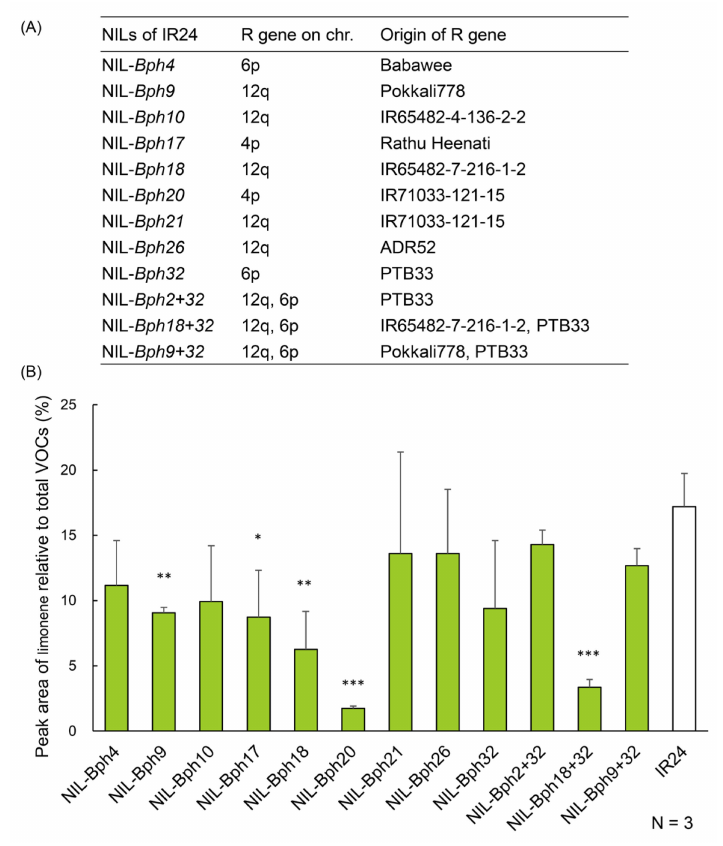
Figure 8. Amounts of limonene in IR24 and IR24-NILs containing various BPH-resistance genes. ( A ) IR24-derived NILs that harbor various BPH-resistance genes. ( B ) Same as in Figure 3. The amounts of limonene in the IR24 line (BPH-sensitive) and IR24-NILs (harboring various BPH- resistance genes) were semi-quantified by GC-MS. Statistical analysis between IR24 and each IR24-NIL was performed independently using Student’s unpaired t -test (N = 3). * p < 0.05, ** p < 0.01, and *** p < 0.001.